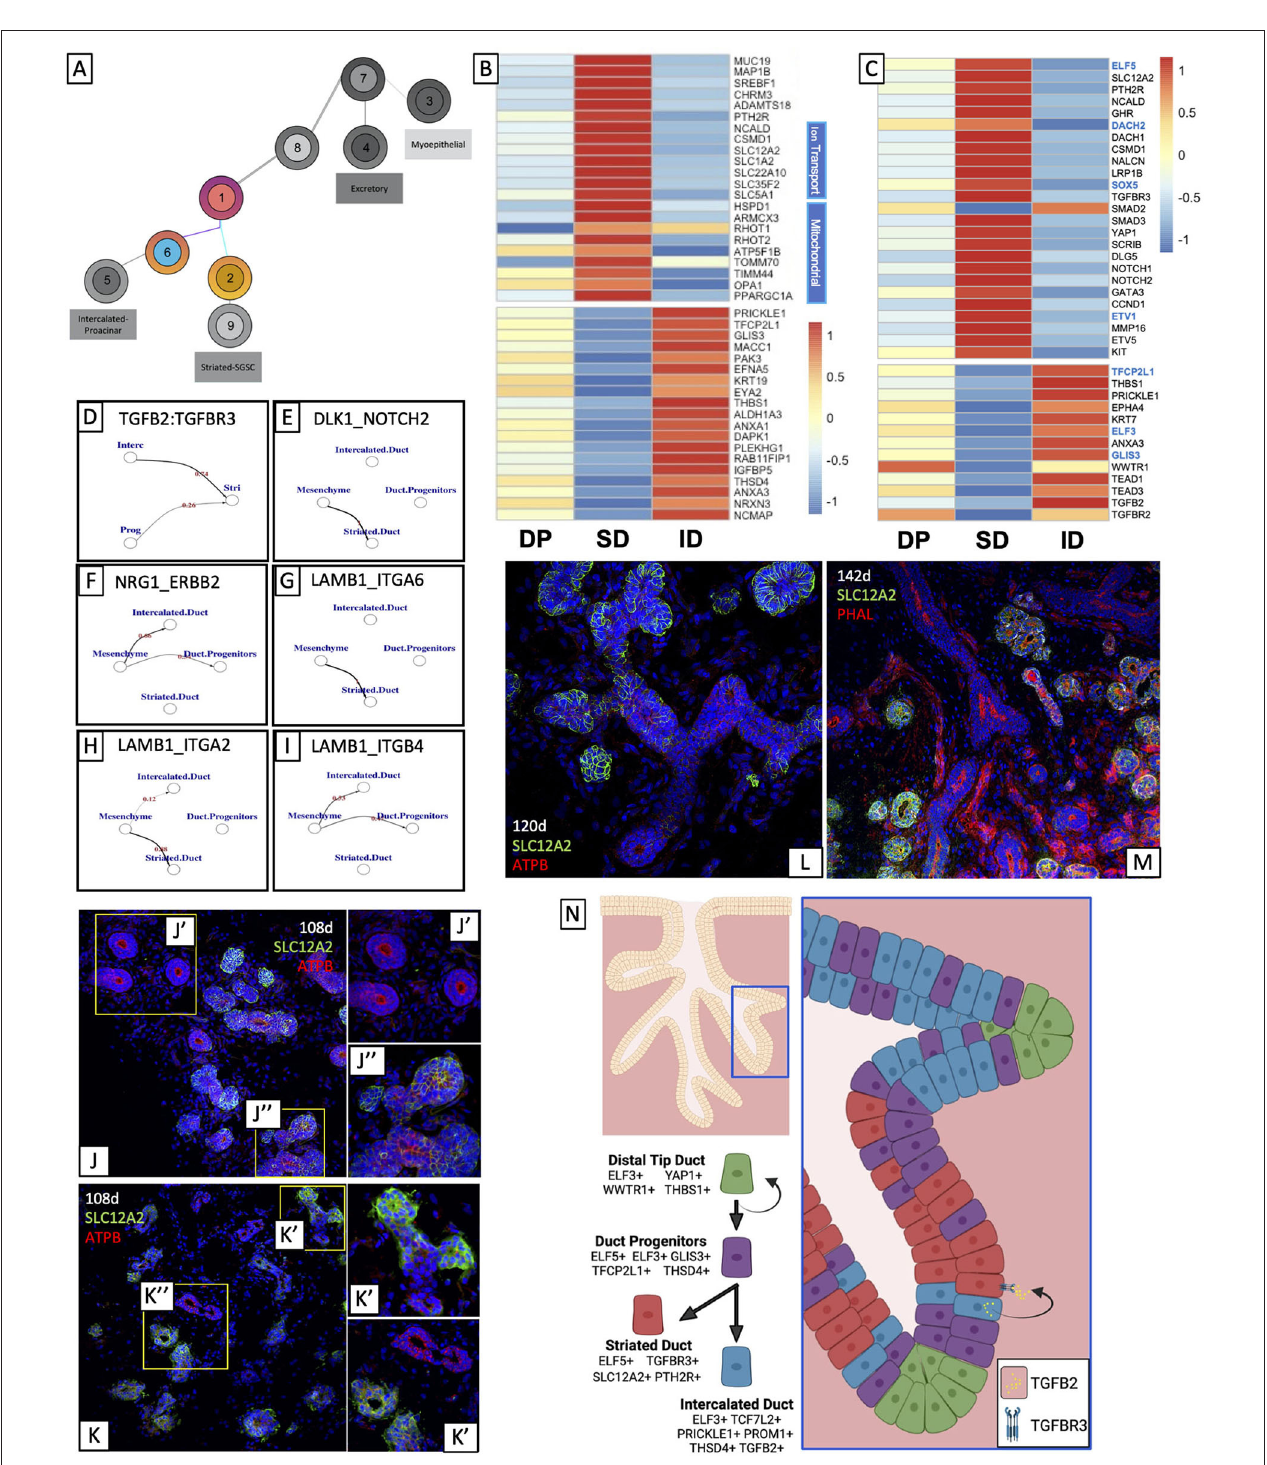
FIGURE 3 | Bifurcation of ductal progenitors relies on differential regulation of secreted signals and cell-cell interaction. (A) DPs split into IDs and SDs. (B) Top gene expression analysis of striated and IDs show that DPs share transcriptional overlap with both striated and ID, but much more so with ID. (C) Differential expression and ChEA3 analysis and ligand-receptor analysis (D–F) suggest that TGF β signaling may promote striated identity while Wnt promotes intercalated identity. ECM-cell interaction analysis (G–I) suggests that interaction between laminin and different integrins may also contribute to this bifurcation. Top marker analysis suggested that SLC12A2 was almost uniquely expressed by SD. We observed expression consistent with this in fetal tissue (J–M) . Analysis suggests that ELF3 and ELF5 mark intercalated and SDs respectively, and that TGFB2 from ID helps to drive TGF β signaling in SD (N) . Created using BioRender.